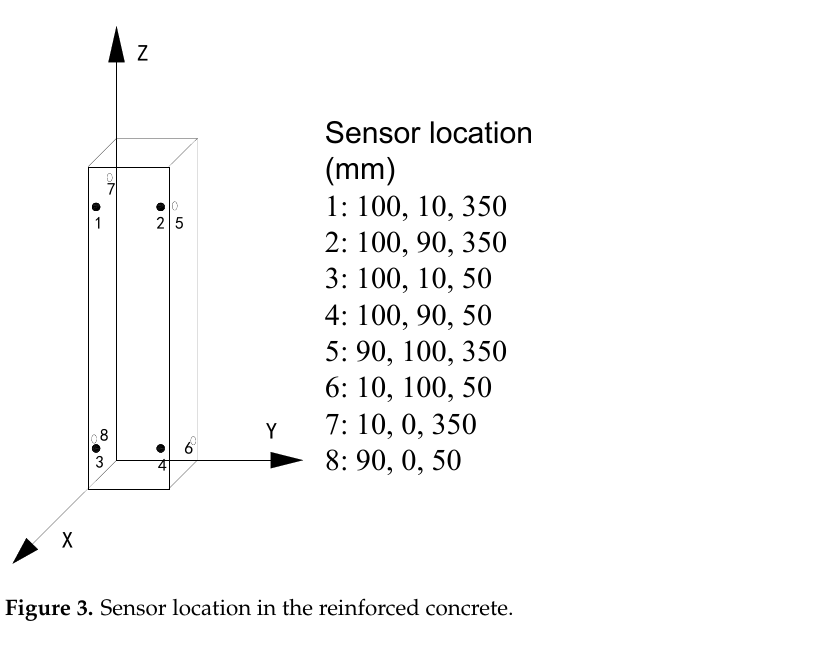
Figure 3. Sensor location in the reinforced concrete.